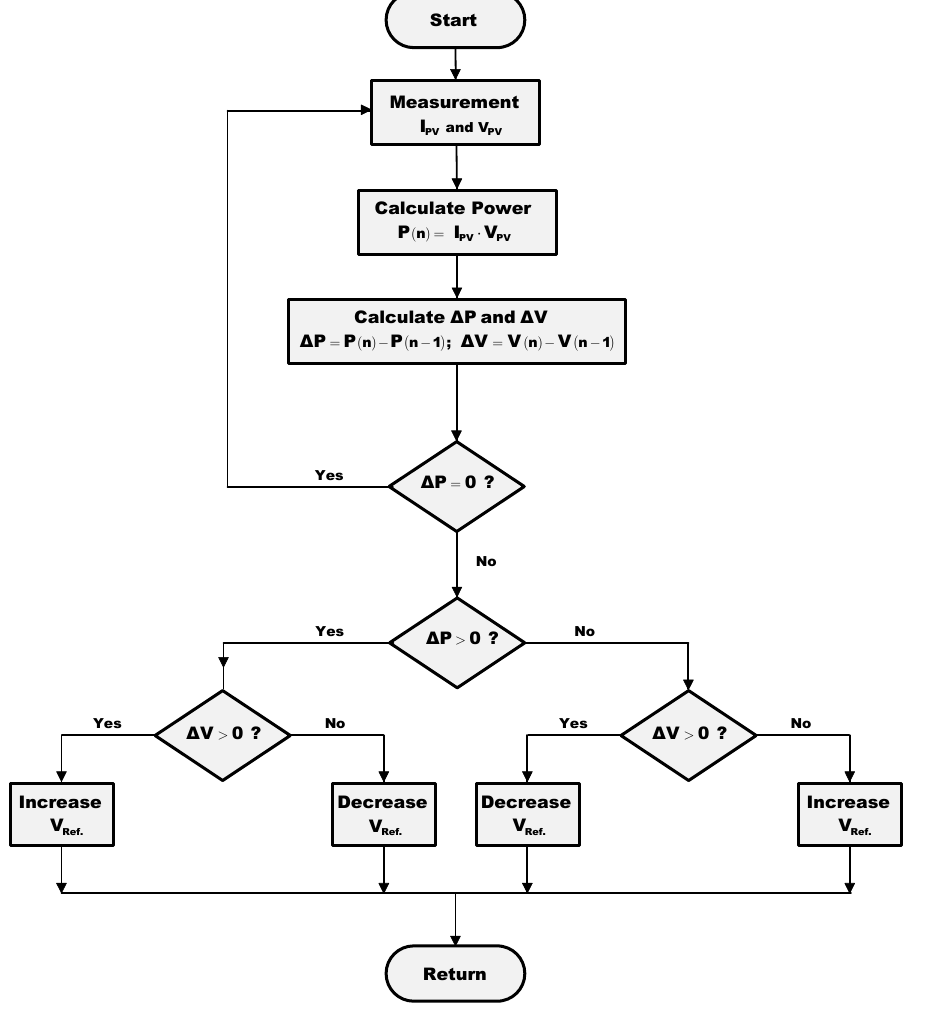
Figure 8. Perturb and observe method flowchart.